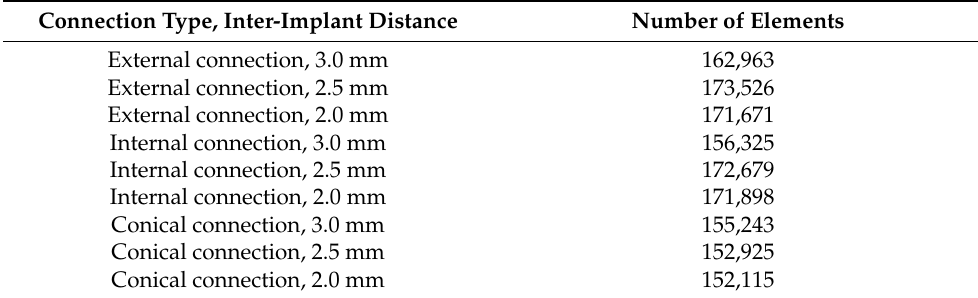
Figure 3. Convergence test results based on the maximum principal stress of bone. The black dots indicate the number of elements where the value of the maximum principal stress converged. EC: external connection; IC: internal connection; CC: conical connection. The mm values indicate the inter-implant distance for each model. Table 2. Number of elements of the analysis